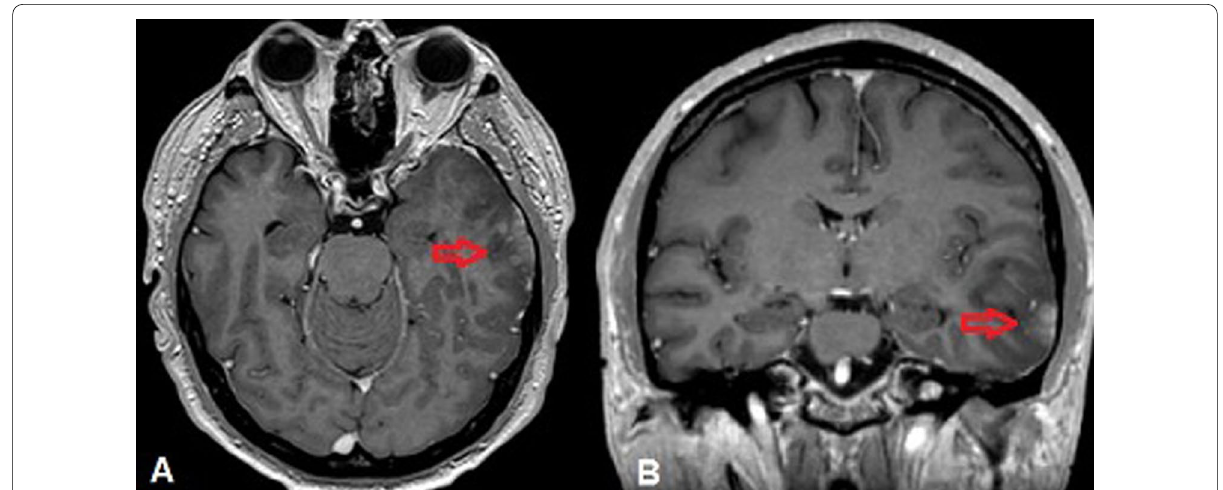
Fig. 1 Brain MRI T1 with contrast axial cut ( A ) and coronal ( B ) visualizing contrast-capturing left temporal lesion (red arrows)